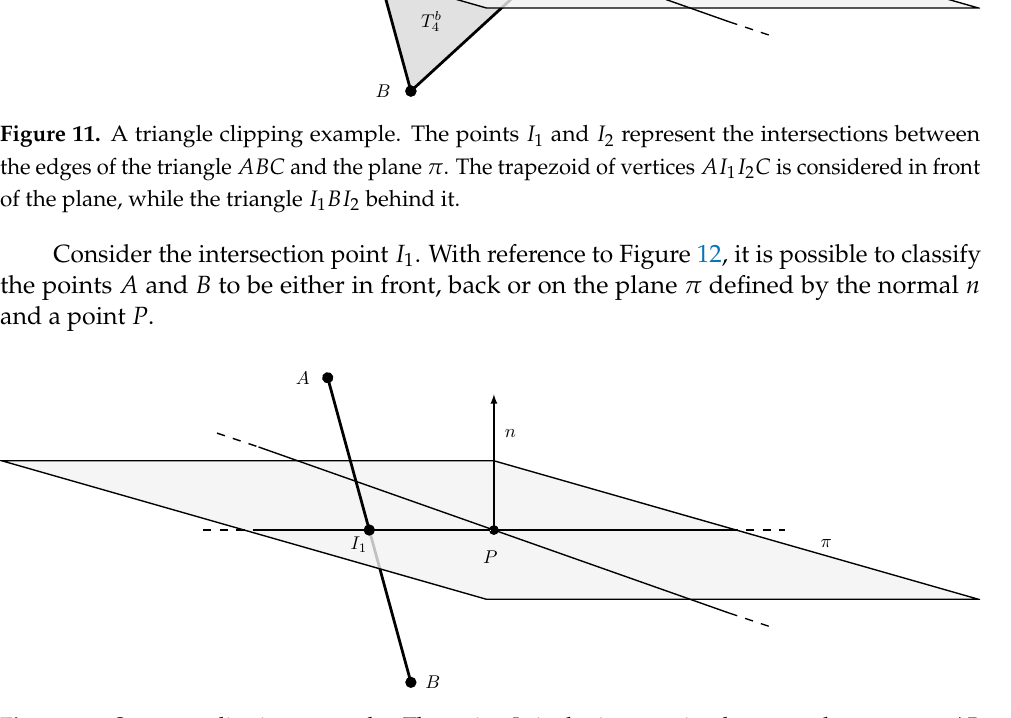
Figure 12. Segment clipping example. The point I 1 is the intersection between the segment AB and the plane π . The segment AI 1 is considered in front of the plane, while BI 1 behind